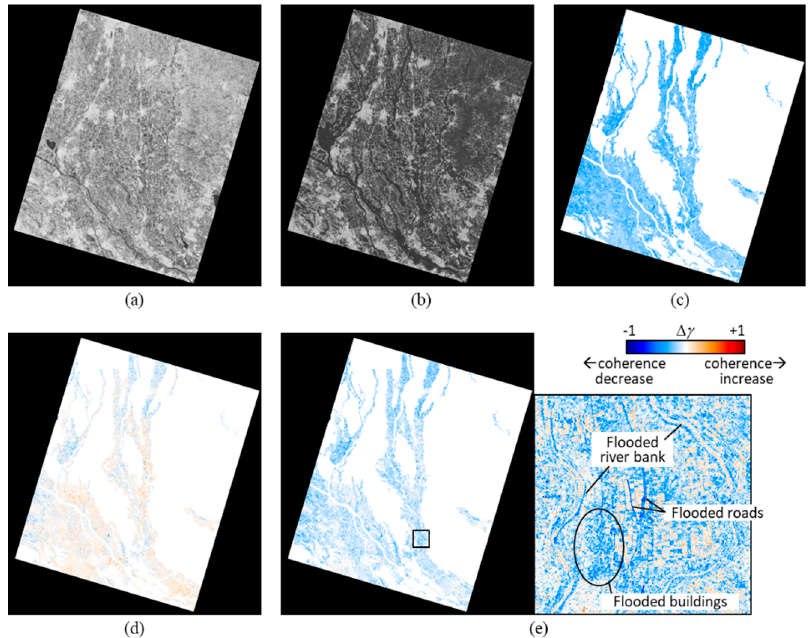
Figure A1. Process of histogram matching used for coherence images in the pre-processing: ( a ) pre-event coherence, ( b ) original co-event coherence, ( c ) coherence difference (co-event − pre-event) using original co-event coherence ( b ), ( d ) using standard coherence matching, ( e ) using proposed masked histogram matching.